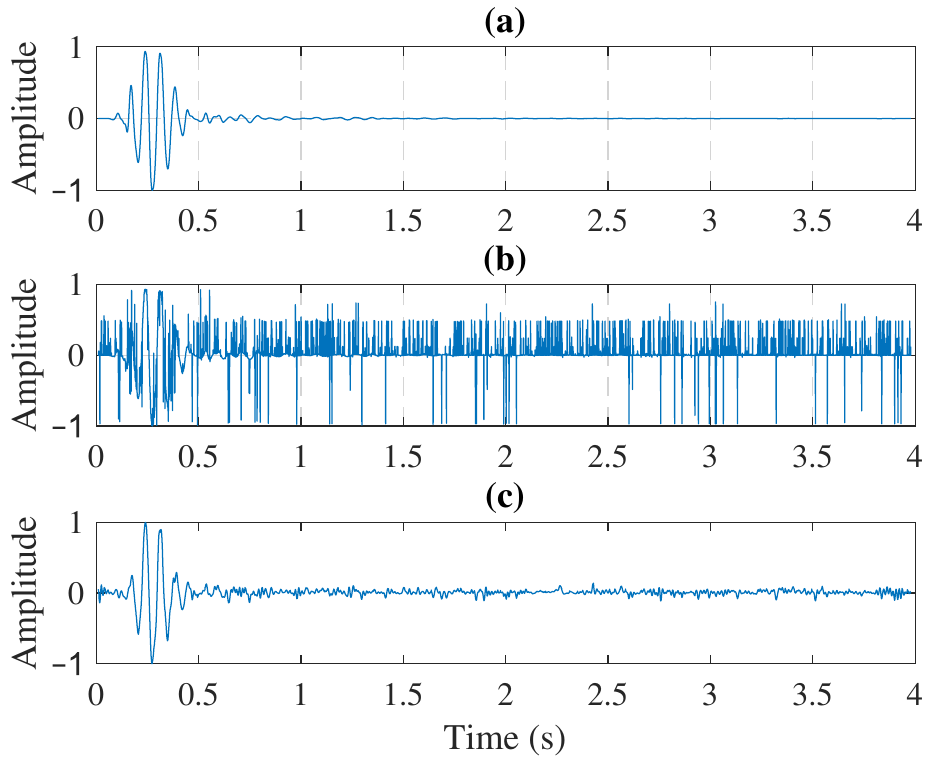
Figure A2. Single trace SNR enhancement (SNR of received data is − 10 dB). ( a ) Original trace. ( b ) Reconstructed trace after MLSE. ( c ) Reconstructed trace after SNR